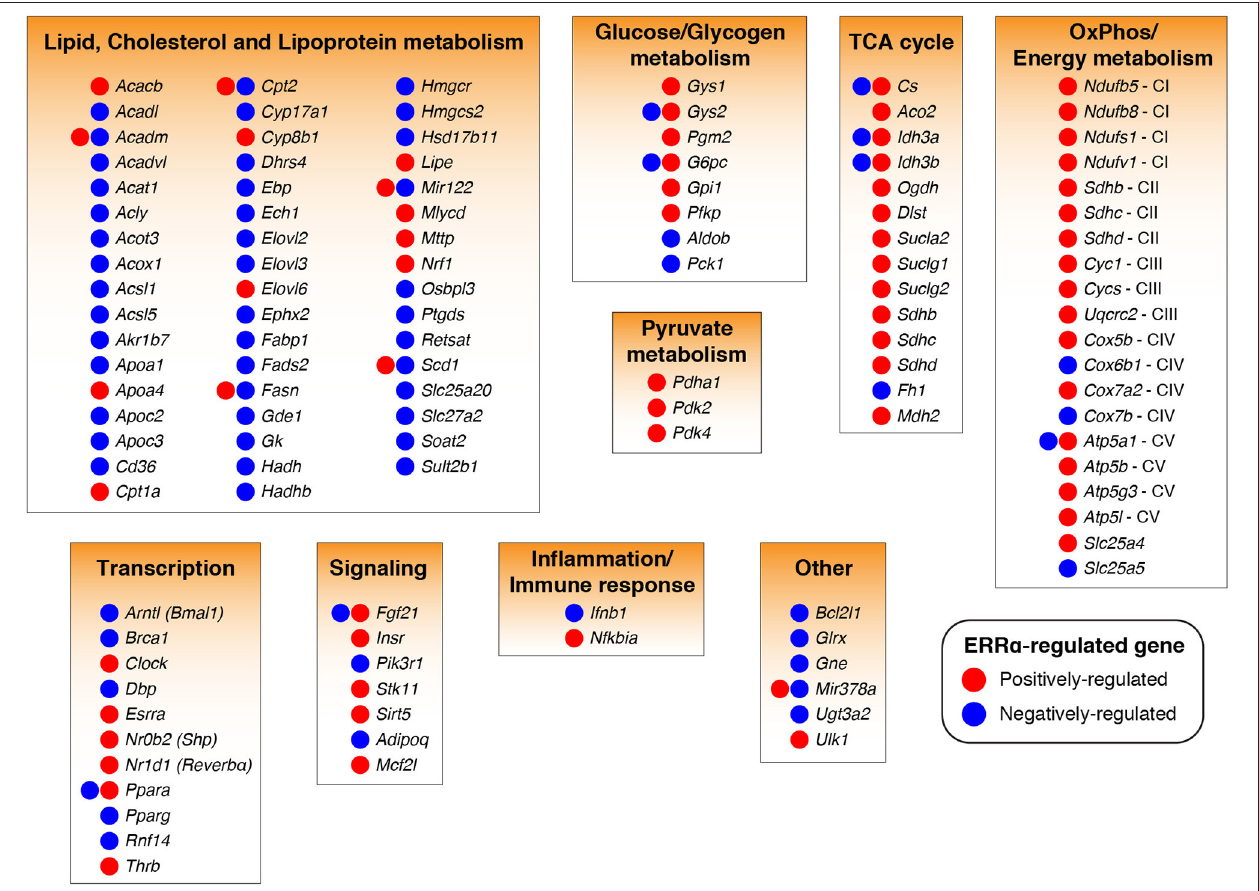
FIGURE 2 | ERR α -regulated target genes and programs in liver cells. ERR α target genes (104) found transcriptionally regulated by ERR α in a positive (increased by ERR α , red) or negative (decreased by ERR α , blue) manner in hepatocytes from in vivo and in vitro studies involving genetic or pharmacological manipulation of ERR α activity are shown. Only ERR α -regulated genes having a high confidence for direct gene regulation by ERR α as determined by the presence of an ERR α -binding event within ± 20kb of the gene transcriptional start site were considered (22, 23). The genes, Sdhb , Sdhc , and Sdhd were associated to two biological programs. See also Table S1 for more